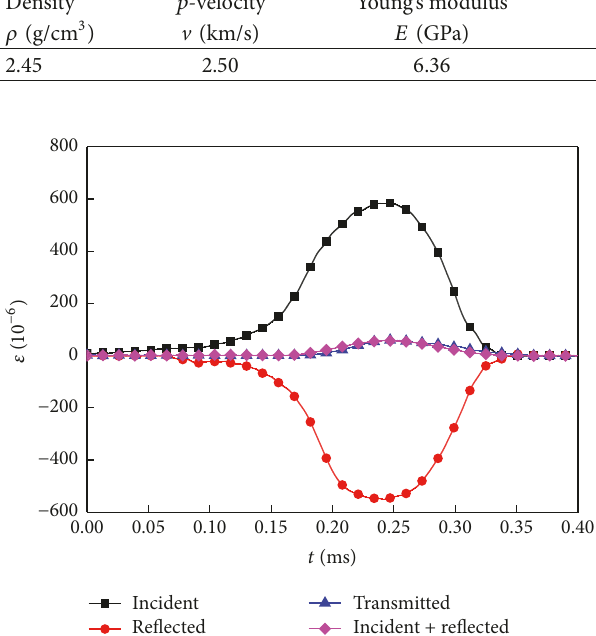
Figure 2: Strain balance check for a typical dynamic SHPB test with pulse shaping.